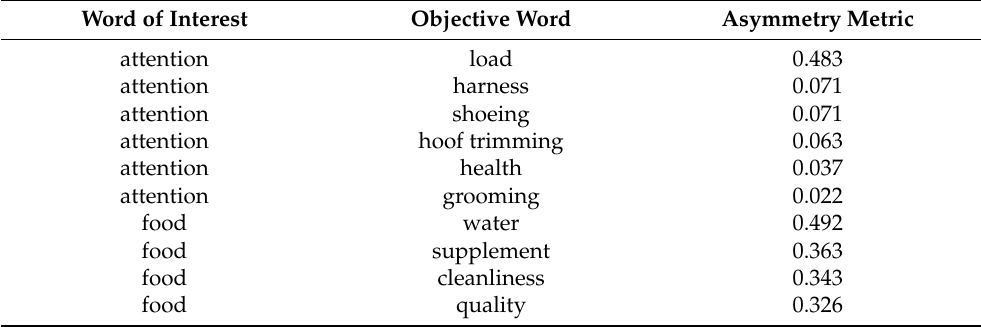
Table 7. Results of the latent semantic analysis in terms of word of interest and objective word and their respective asymmetry metric for the question, “What are the most important resources that mules need to be able to work?”